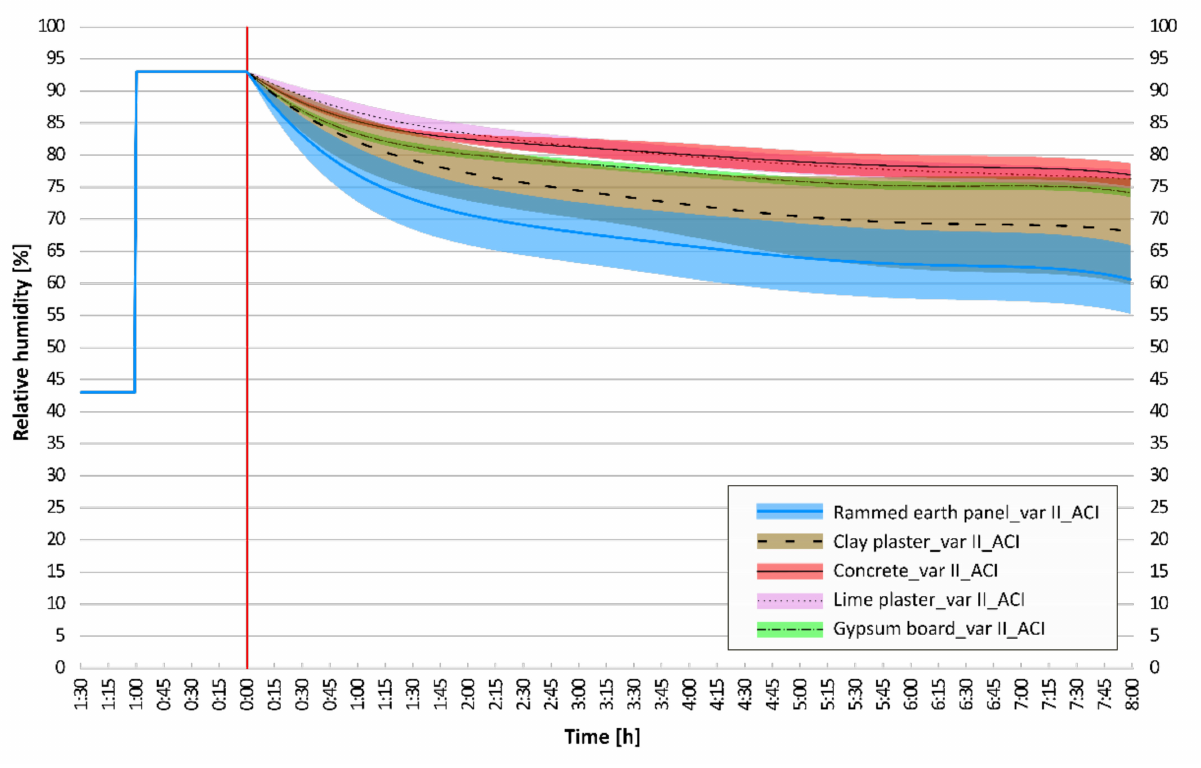
Figure 12. Comparison of adjusted confidence intervals: rammed earth panel, clay plaster, concrete, lime plaster, gypsum